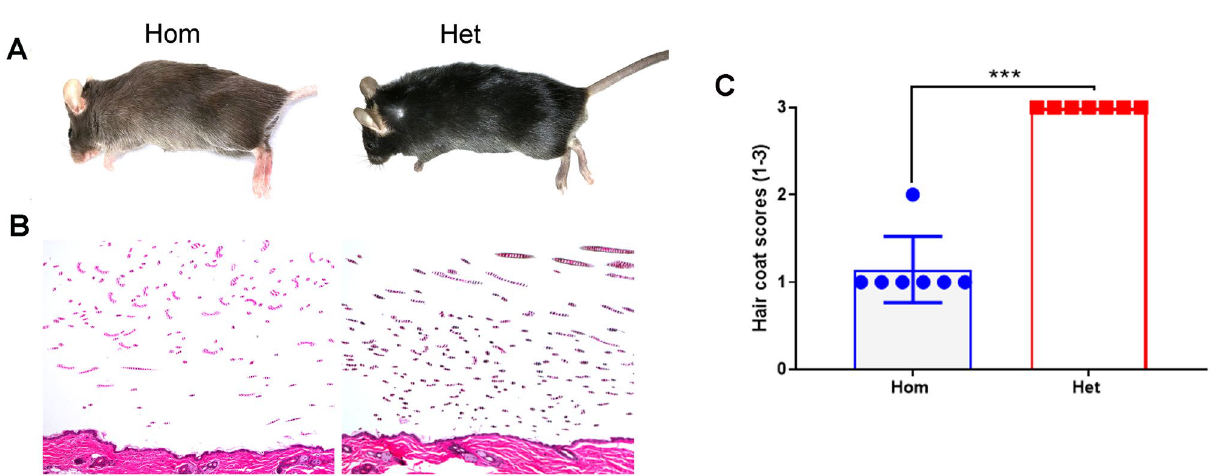
Figure 7. Hair coat color in Hom- Pah KO mice. The difference in hair coat color is grossly visible ( A ). Hair coat of the Hom mouse is light brown whereas it is dark brown for the Het mouse. ( B ) Hair shafts from the Hom mouse contain less melanin pigment when compared to the Het mouse. H&E stain 20× ( C ) Summary of hair melanin scores is shown in the scatter plot graph. n = 7 Hom, 7 Het. Bars indicate group median score and the error bars indicate range (*** p =